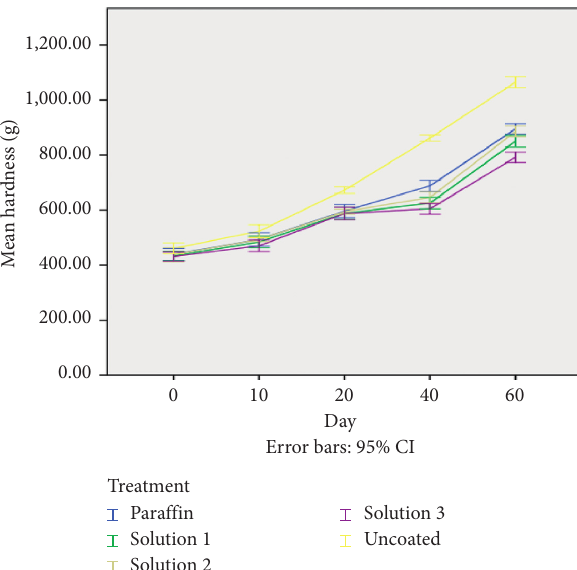
Figure 10: Values (means ± SD) of the fat content of cheese coated with antimicrobial edible coating solutions—solution 1 (0.250 g/L Delvocid), solution 2 (0.275 g/L Delvocid), and solution 3 (0.300 g/ L Delvocid)—compared with cheese coated with commercial coating and uncoated cheese throughout 60d of storage at 10 ° C and 85% relative humidity.